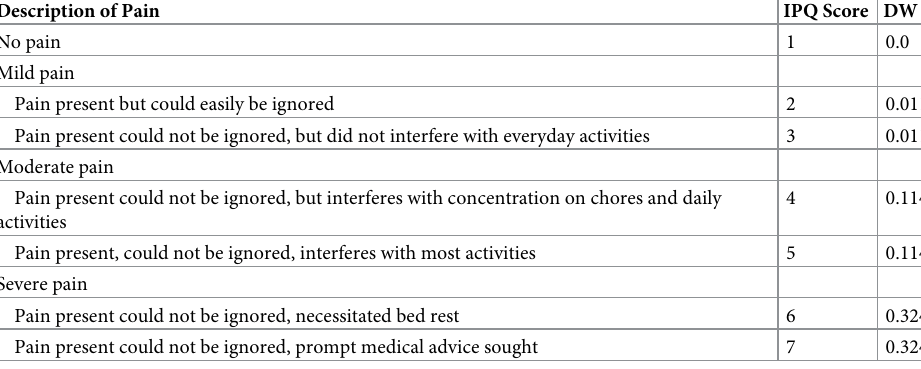
Table 1. Conversion of Inguinal Pain Questionnaire (IPQ) Score to Disability Weight (DW) according to the Global Burden of Disease 2017